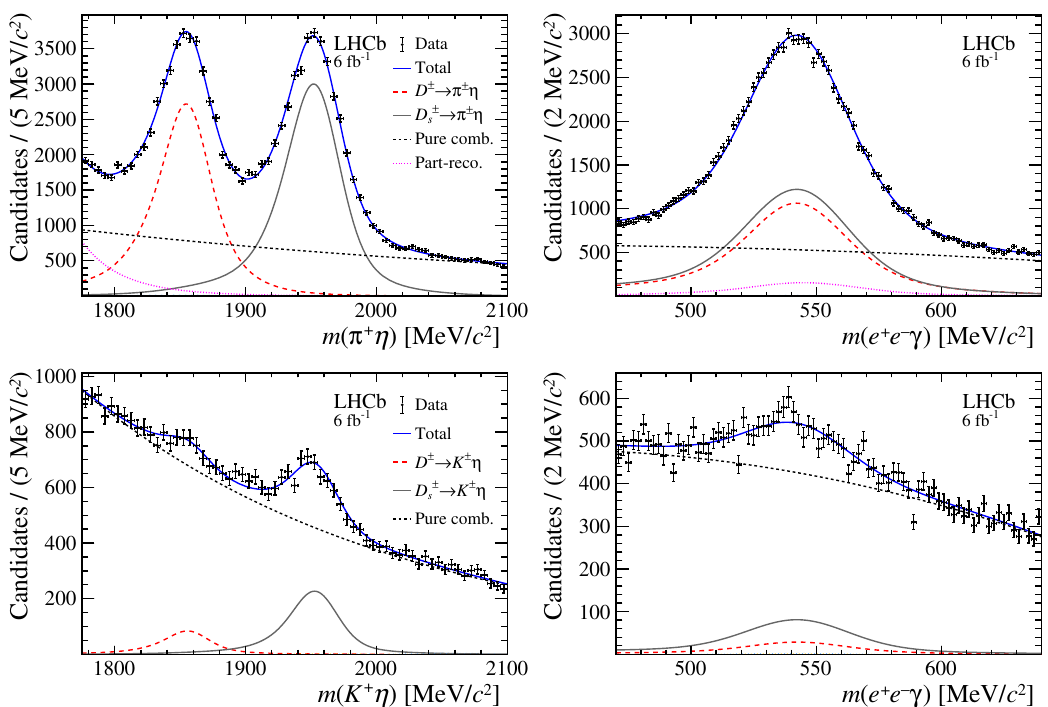
Figure 3. Distribution of the (left) m ( h + η ) and (right) m ( e + e − γ ) mass for (top) D + (bottom) D + → K + η candidates, summed over all categories of the simultaneous fit. Projections ( s ) of the total fit result and individual fit components are overlaid. This includes D + → h + η decays in dashed red, D + → h + η decays in solid grey, pure combinatorial decays in dashed black and partially s reconstructed background in dotted magenta. The misidentification background is too small to be seen in these